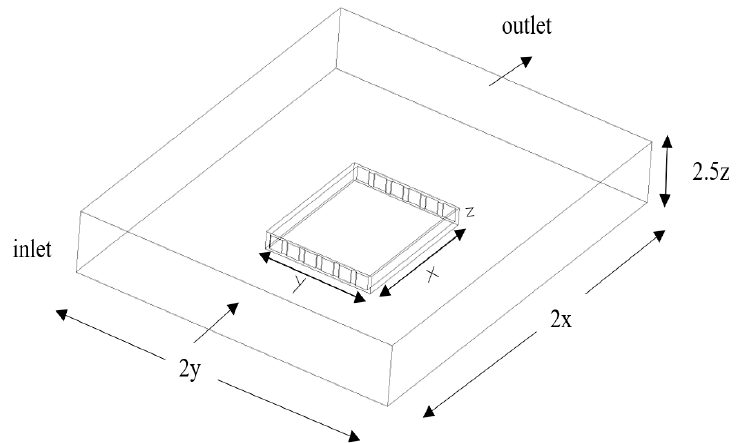
Figure 2. Benchmark model geometry. Table 6. Geometry create in workbench.